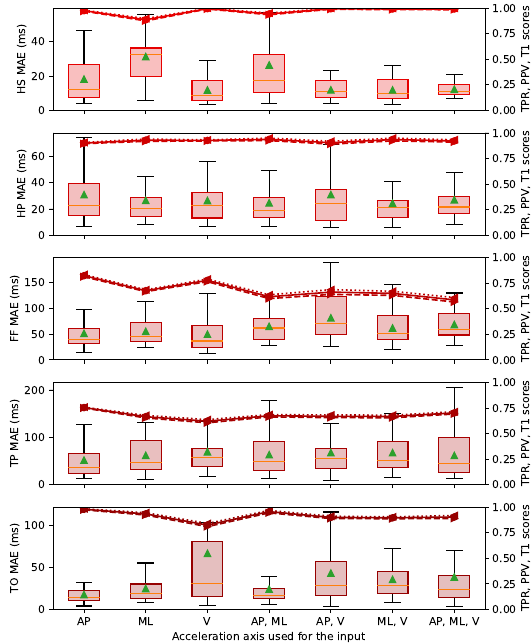
Figure 11. Same as Figure 10 for the CIRRIS database. The ESN for GED on subset CIR all with foot IMU